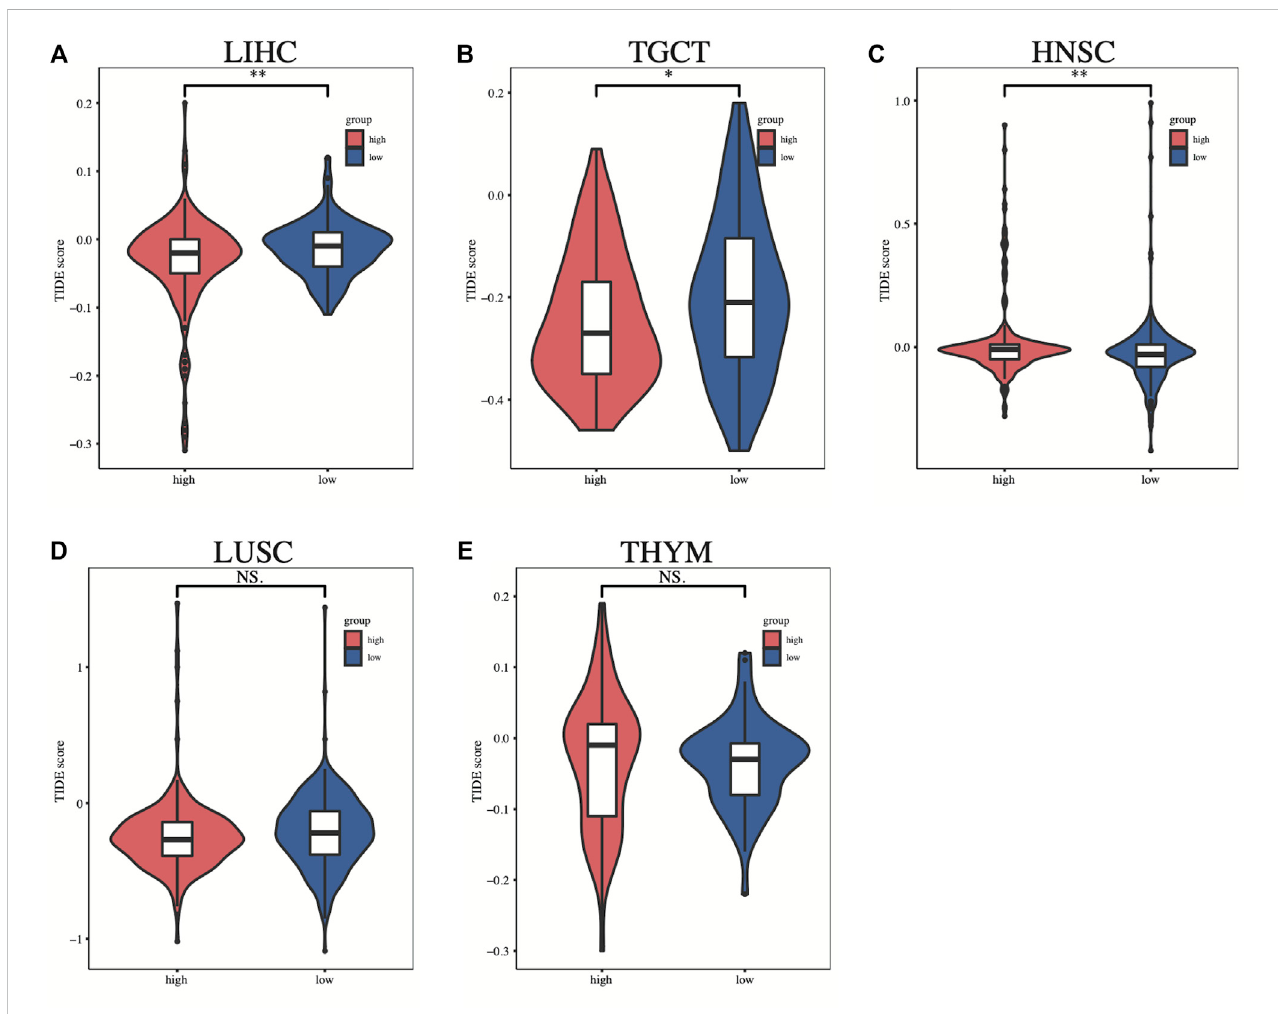
FIGURE 9 The difference in TIDE scores between the high and low SLC2A1 expression groups in (A) LIHC (B) TGCT (C) HNSC (D) LUSC (E) UVM. TIDE, tumor immune dysfunction and exclusion. * p < 0.05; ** p < 0.01; *** p <